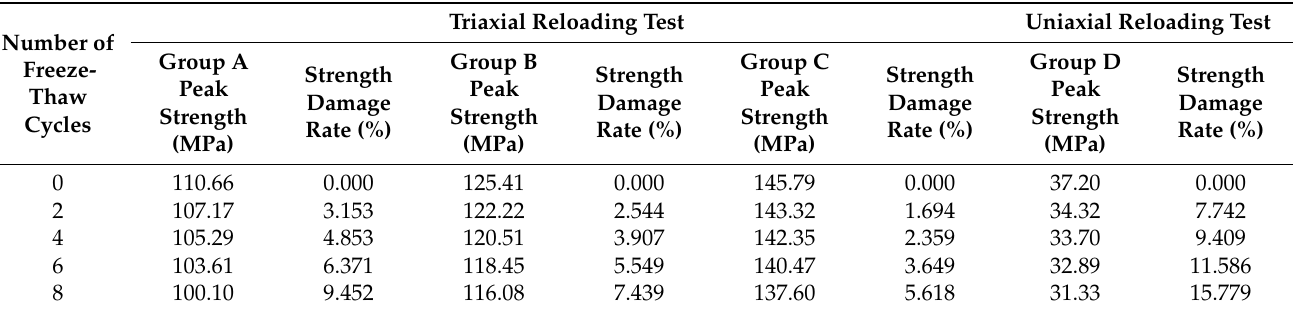
Table 2. Unloaded-damaged samples uniaxial and triaxial reloading peak strength.